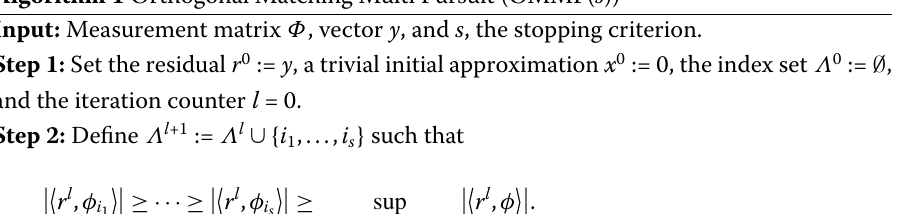
Algorithm 1 Orthogonal Matching Multi Pursuit (OMMP( s